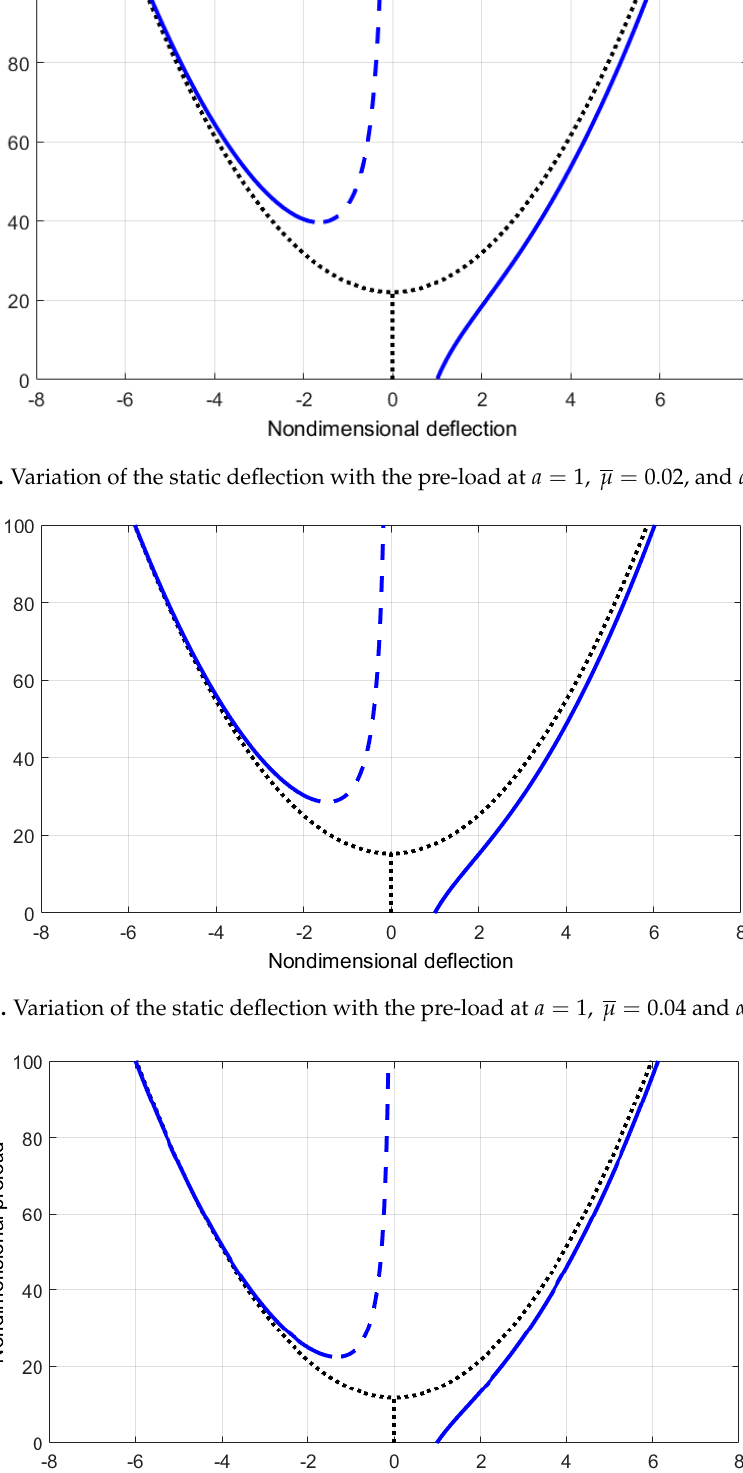
Figure 7. Variation of the static deflection with the pre-load at 𝑎 = 1,𝜇̅ = 0.06 and 𝛼 = 1 .